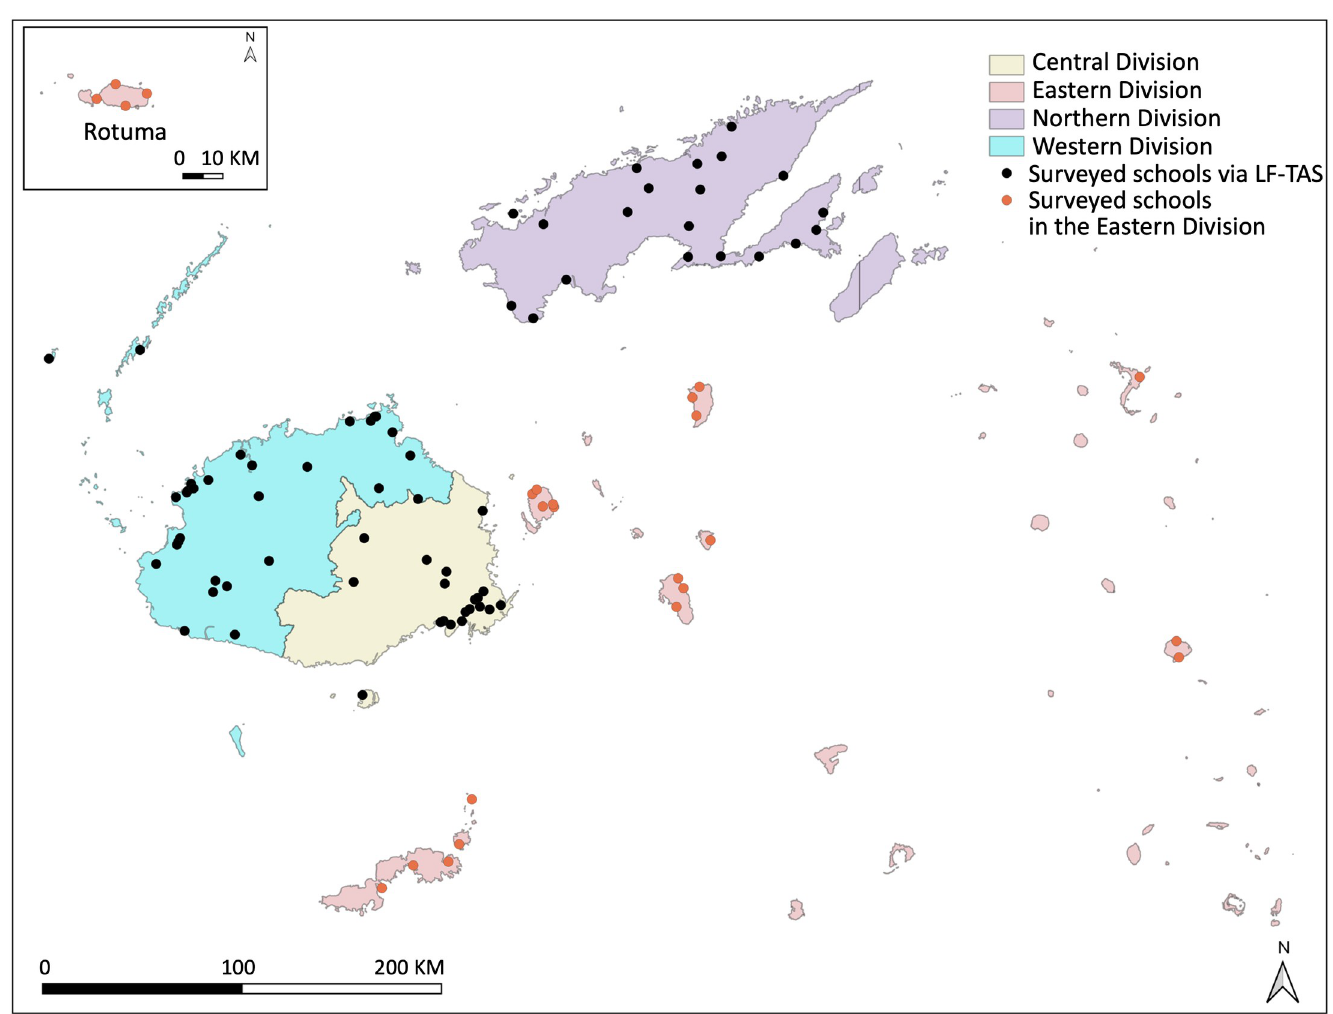
Fig 2. Sketch map of selected schools for the STH prevalence assessment in the four � Divisions of Fiji � The Taveuni sub-Division is not included. Data source; GADM database of Global Administrative Areas, August 2019.